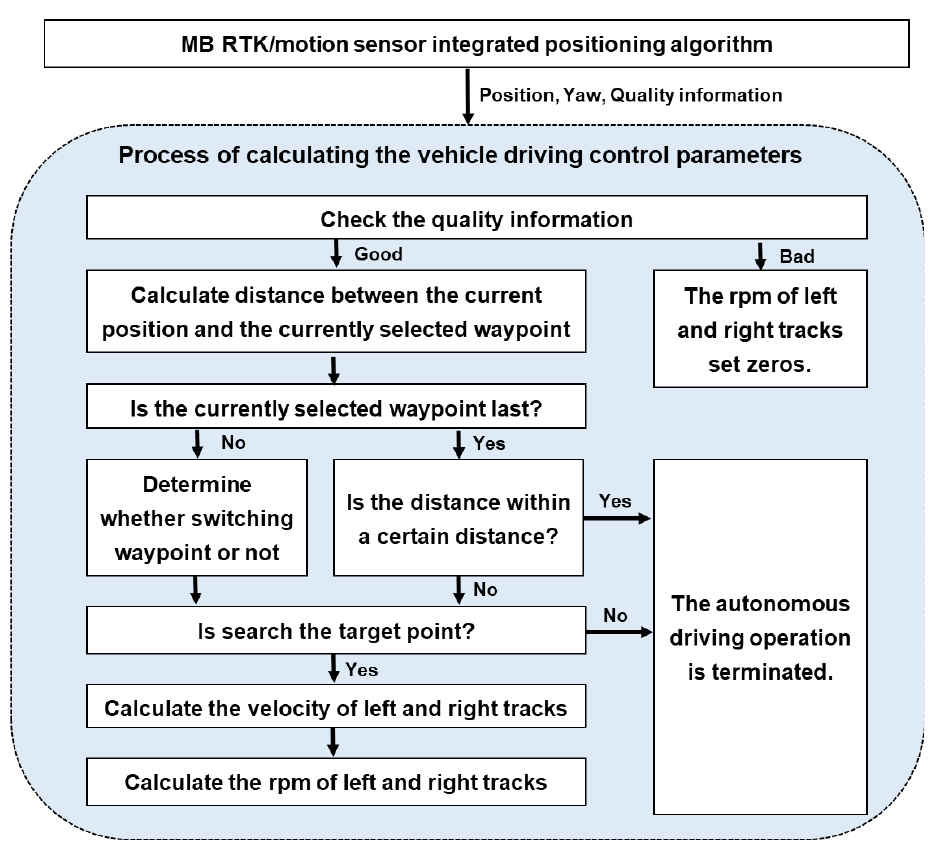
Figure 4. Process of calculating the vehicle driving control parameters, which are the rpm of the left and right tracks.